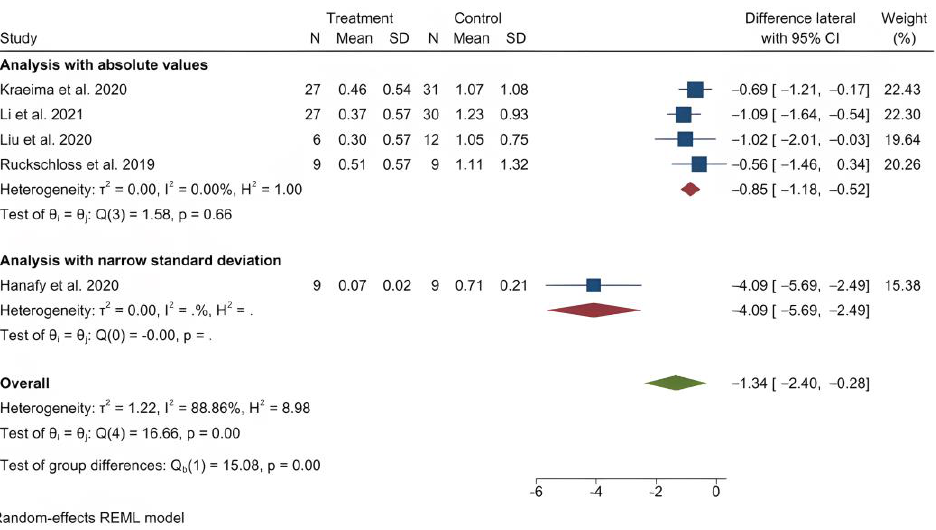
Figure 9. Forest plot showing differences in lateral deviation between PSI and control (conventional osteosynthesis and CAD/CAM splint or wafer).